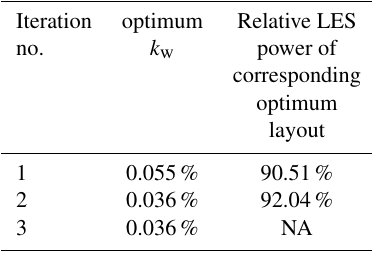
Table 4. Iteration 1: comparing outputs of LES and Jensen wake model with k w = 0.055.